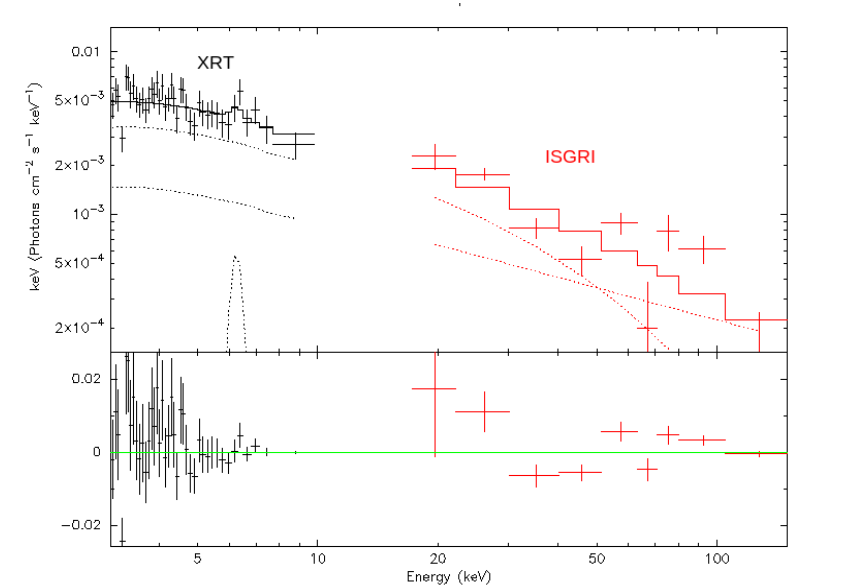
Figure A7. Unfolded SWIFT/XRT and INTEGRAL/ISGRI spectra of 3C 111 during 7th (January 2010) observational period and model. Above: all the spectra are shown by crosses; fitting curves are shown by solid lines; model components are shown by dotted lines; below: data residuals. During this period nuclear emission was dominating significantly over jet base one; despite the quite poor quality of the XRT spectrum the signs of weak Fe-K α emission line are visible.